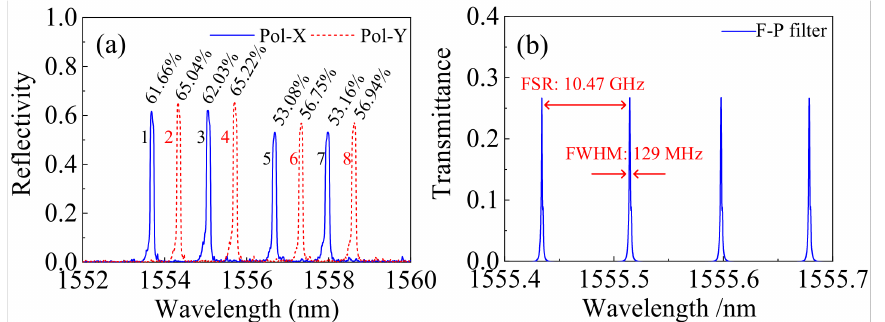
Figure 2. ( a ) Pure reflection spectrum of CSI-HBFBG measured by polarized light in a normalized linear scale. ( b ) Transmission spectrum of the F-P